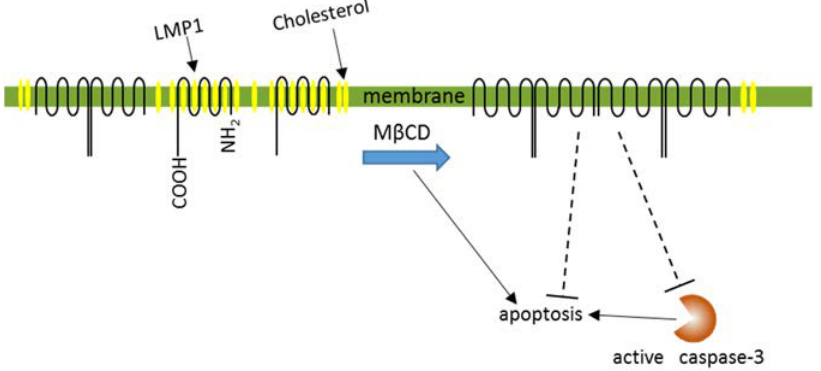
Fig. 6. Schematic ¯gure showing that relationship among lipid rafts, LMP1/LMP1 interaction and cell